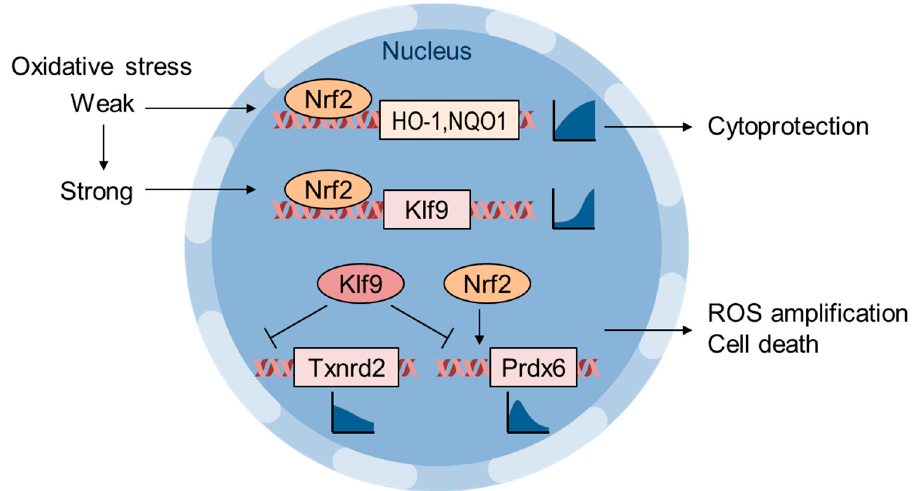
Figure 4. Weak and strong oxidative stresses induce differential gene expression via the Nrf2 and Klf9 axes. Nrf2 induces the expression of cytoprotective genes, such as HO-1 and NQO1, in response to a wide range of oxidative stresses [88] . High-dose H 2 O 2 or sulforaphane induces Klf9 expression, which represses Txnrd2 gene expression as well as that of other Nrf2-target genes, such as Prdx6, and induces cytotoxic ROS production [88,89] . The line graphs represent the oxidative stress level ( x -axis) cytotoxic ROS production [88,89]. The line graphs represent the oxidative stress level ( x -axis) and transcription ( y -axis) and transcription ( y -axis) relationship.